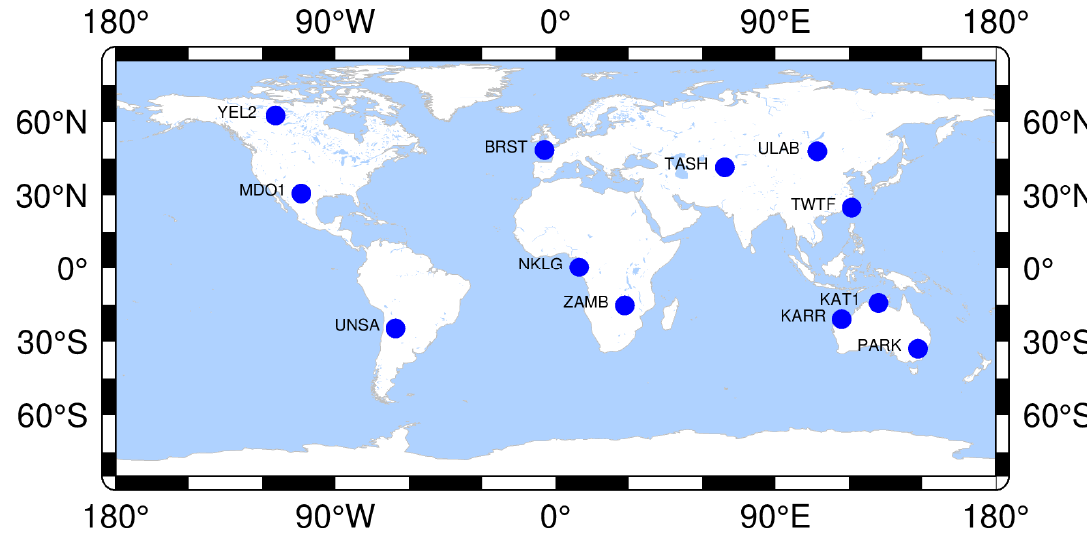
Figure 14. Distribution of stations for kinematic PPP validations.